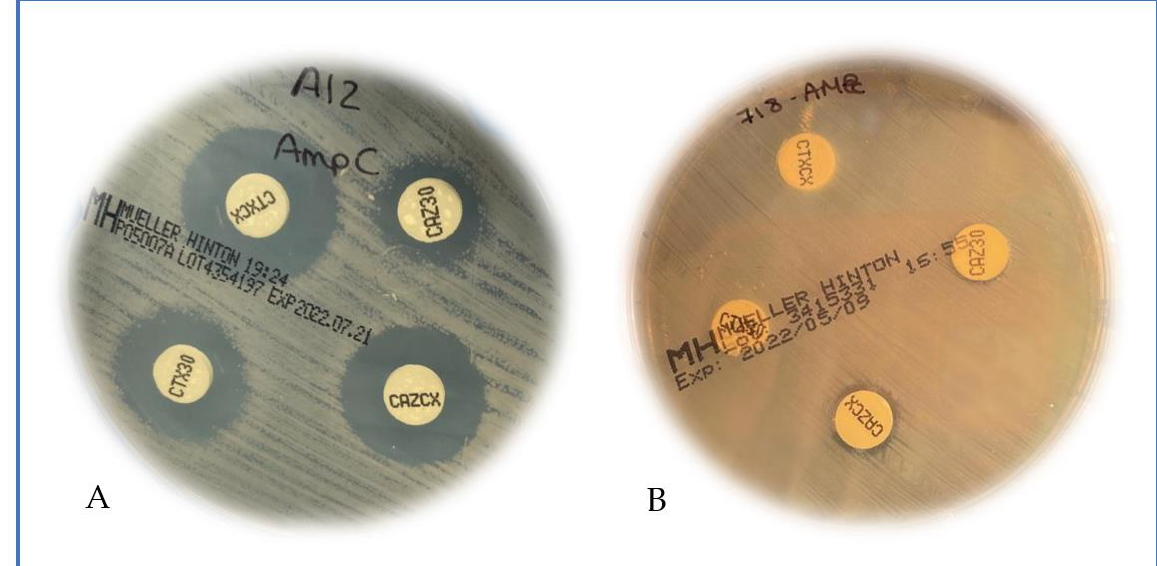
Figure 1. Phenotypic inhibitor-based methods (disk diffusion); ( A ): pAmpC positive, difference of ≥5 mm between one or both cephalosporins when comparing with the inhibitor tablet; ( B ): pAmpC negative, no differences between cephalosporins disks and corresponding inhibitors.